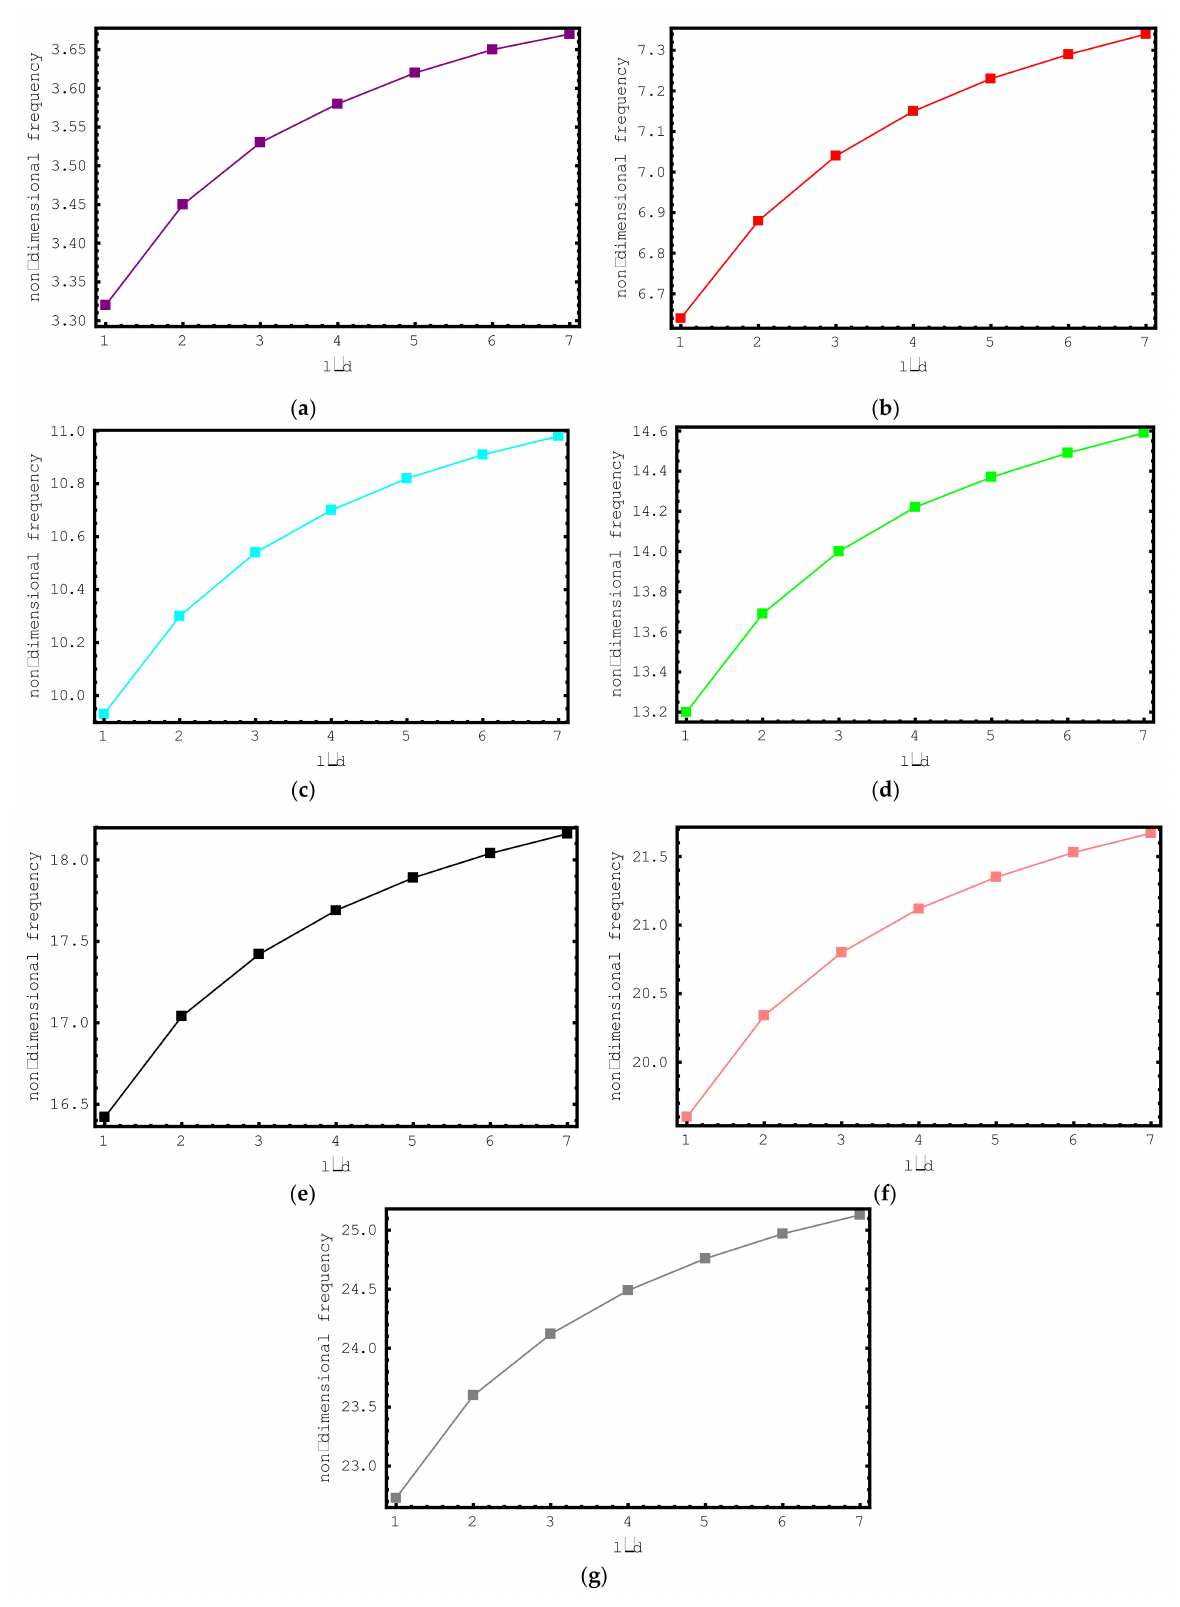
Figure 4. The variations of non-dimensional frequencies of short-fiber-reinforced composite nano- rods versus l / d : ( a ) 1st mode ( b ) 2nd mode ( c ) 3rd mode ( d ) 4th mode ( e ) 5th mode ( f ) 6th mode ( g ) 7th